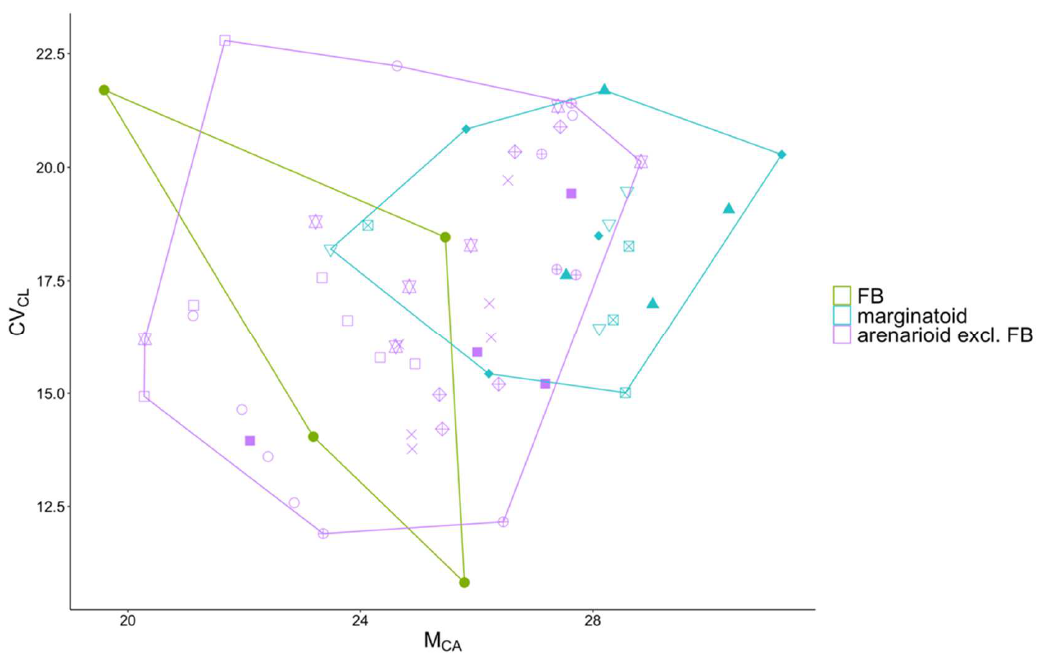
Figure 4. Scatterplot of the two karyotype asymmetry indices M CA vs. CV CL in Armeria arenaria . Accessions are enclosed by convex hulls according to grouping hypothesis II derived from the morphometric and seed morpho–colorimetric analysis, which sees LL as belonging to the same group as all the other Northern Italian arenarioid populations against the single population FB (which corresponds to A. arenaria s.str.). Symbols of populations as in Figure 1. FB = Fontainebleau, Île–de–France.